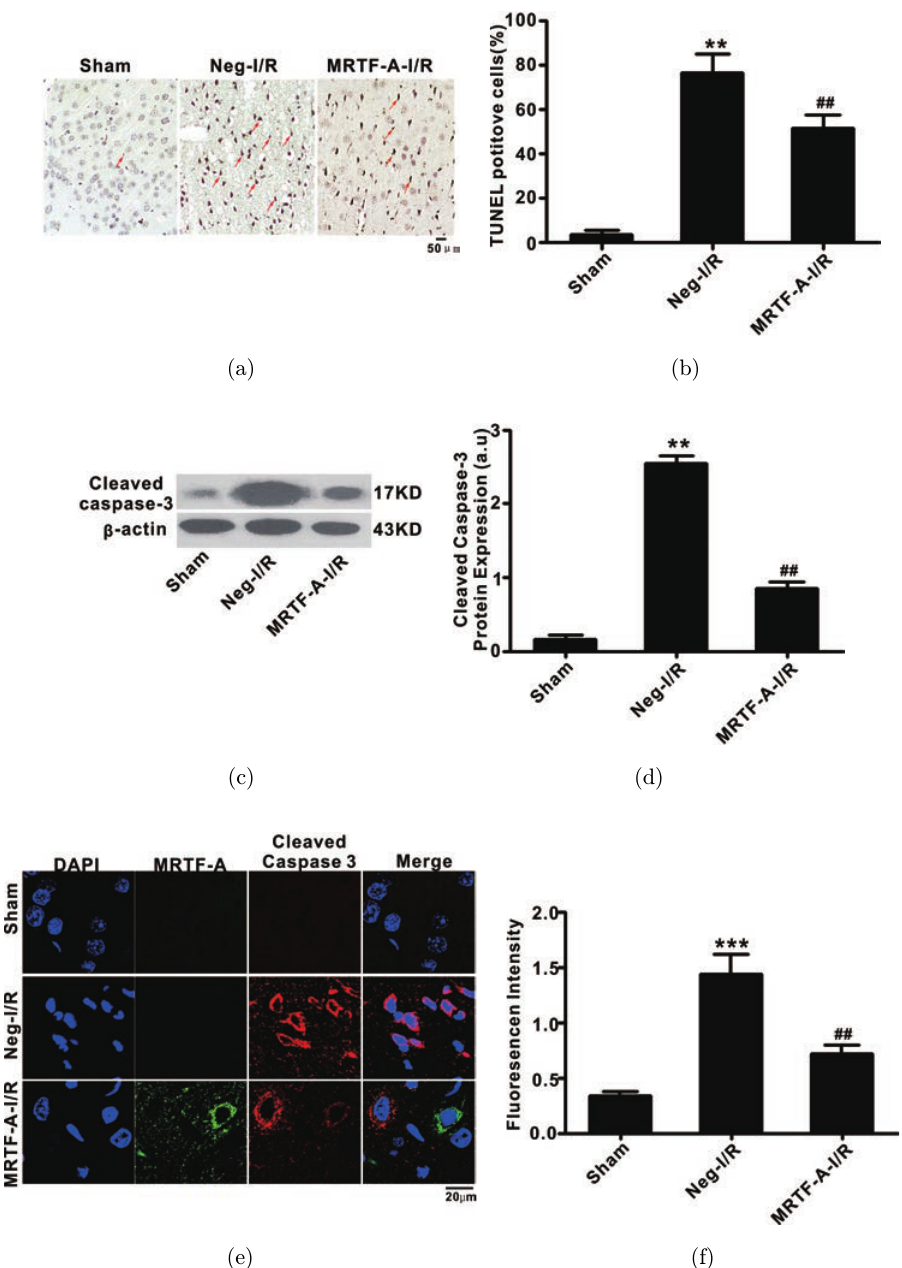
Fig. 2. E®ect of MRTF-A overexpression on apoptosis induced by cerebral I/R injury. Apoptosis was identi¯ed using the TUNEL assay; the expression of the cleaved caspase-3 was analyzed via western blot analysis and immuno°uorescence staining. (a) The red arrow represented TUNEL-positive cells. (b) Quanti¯cation of cell apoptosis ratio (%). (c) and (d) The protein expression of cleaved caspase-3 was tested via western blot analysis. (e) Images of the immuno°uorescence assay for cleaved caspase-3 expression. (f) The intensity of cleaved caspase-3 °uorescence was quanti¯ed using the Image J software. * P < 0 : 05, ** P < 0 : 01, *** P < 0 : 001 versus the sham group, # P < 0 : 05, ## P < 0 : 01 versus the Neg-I/R group. Data were presented as mean (cid:1) SD, n ¼ 6.